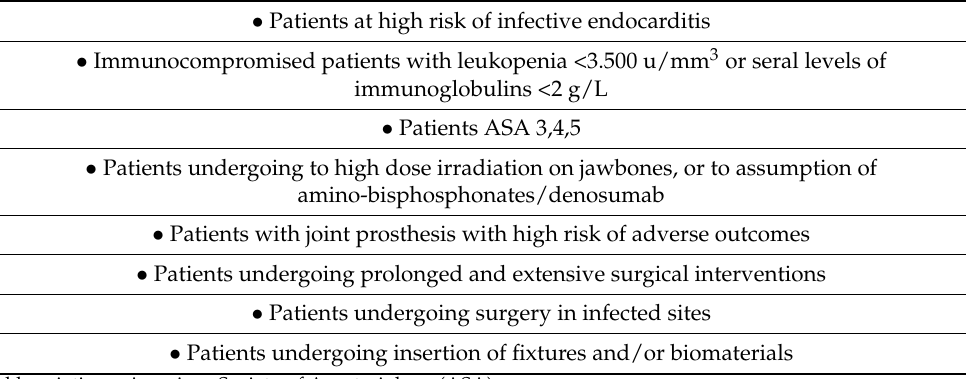
Table 3. Categories of patients where antibiotic prophilaxis is